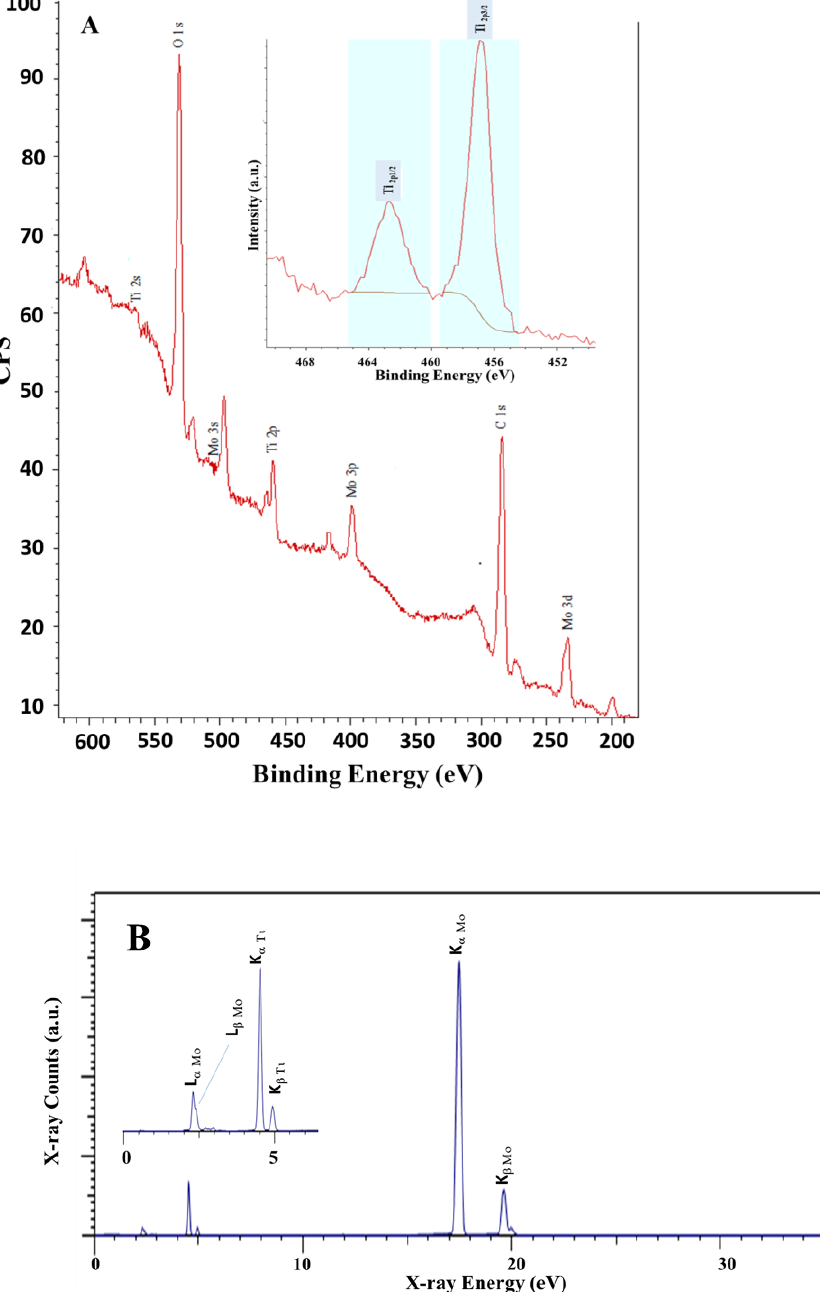
Figure 4. Surface analyses for Ti-Mo NC ( A ) XPS and ( B ) XRF spectra.